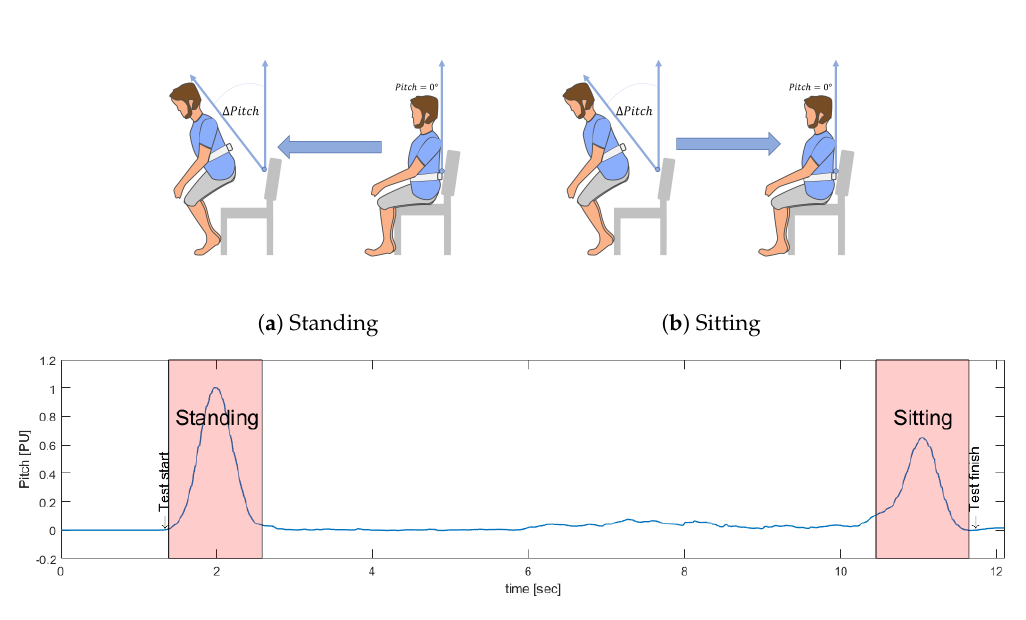
Figure 4. Identification of Standing/Sitting events using Pitch